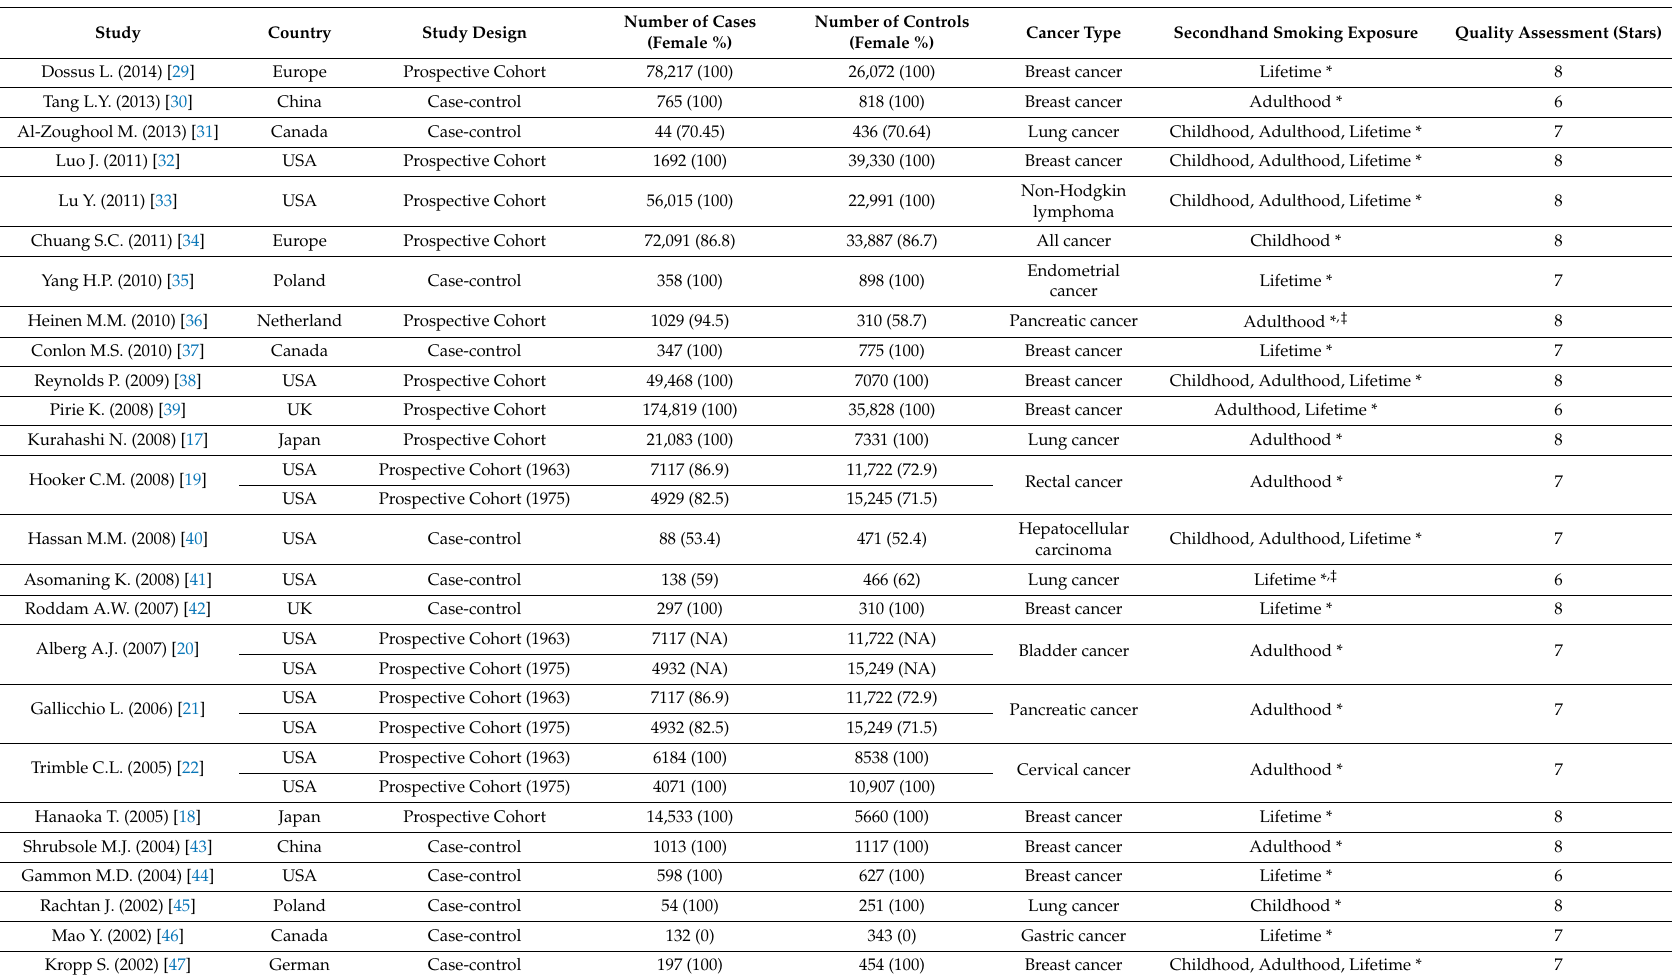
Table 1. Characteristics of selected studies on the relationship between secondhand smoking and cancer among never